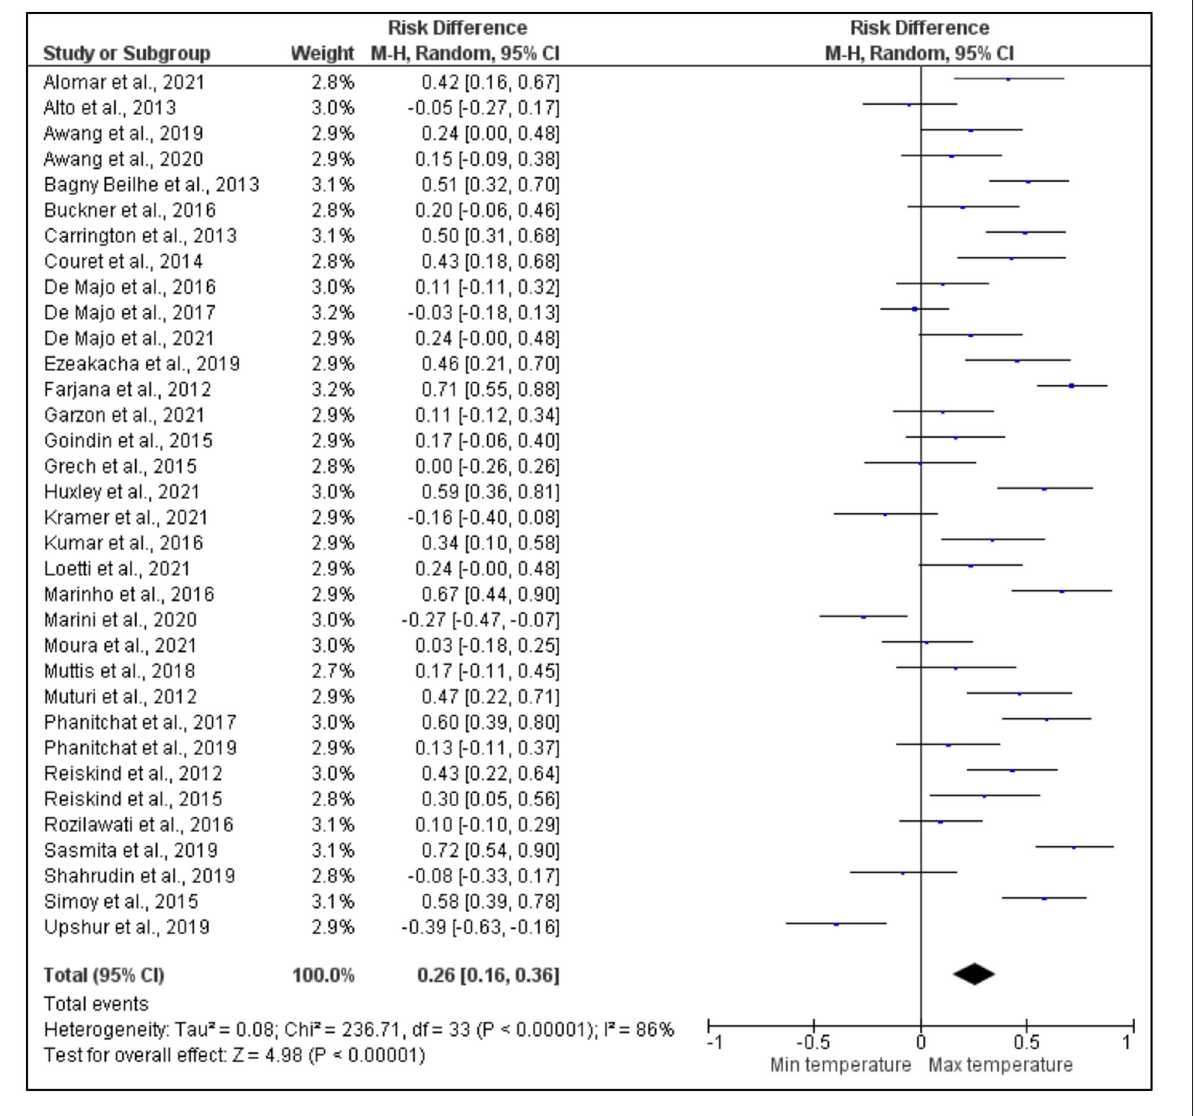
FIGURE4 Forest plot of comparison of the effect of minimum temperature vs. maximum temperature on the development period of Aedes